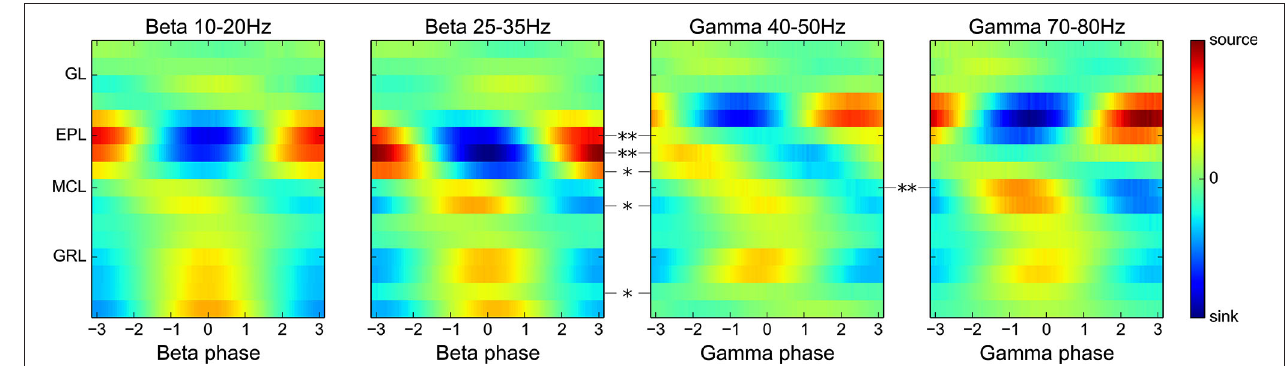
(assessed by an electrode-by-electrode modulation amplitude comparison) are found between the beta and gamma maps and not between the low and high frequency range maps for the same oscillation type (in plot order: N = 16, 14, 11, 18). The color scales are distinct for the beta and gamma maps for better visualization.